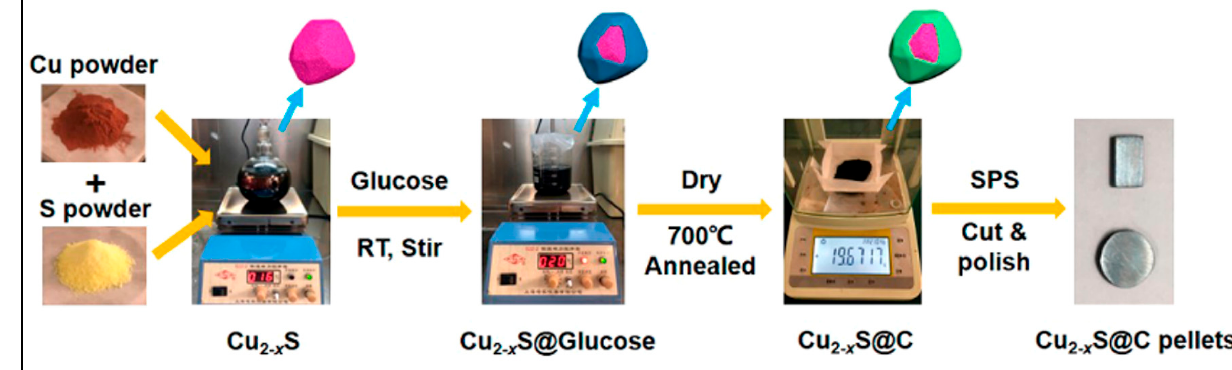
Figure 3. Schematic illustration of the carbon-encapsulated copper sul fi de (Cu2 − xS@C) composite synthesis process. Reproduced with permission from [61]. Copyright ACS Publications, 2019.